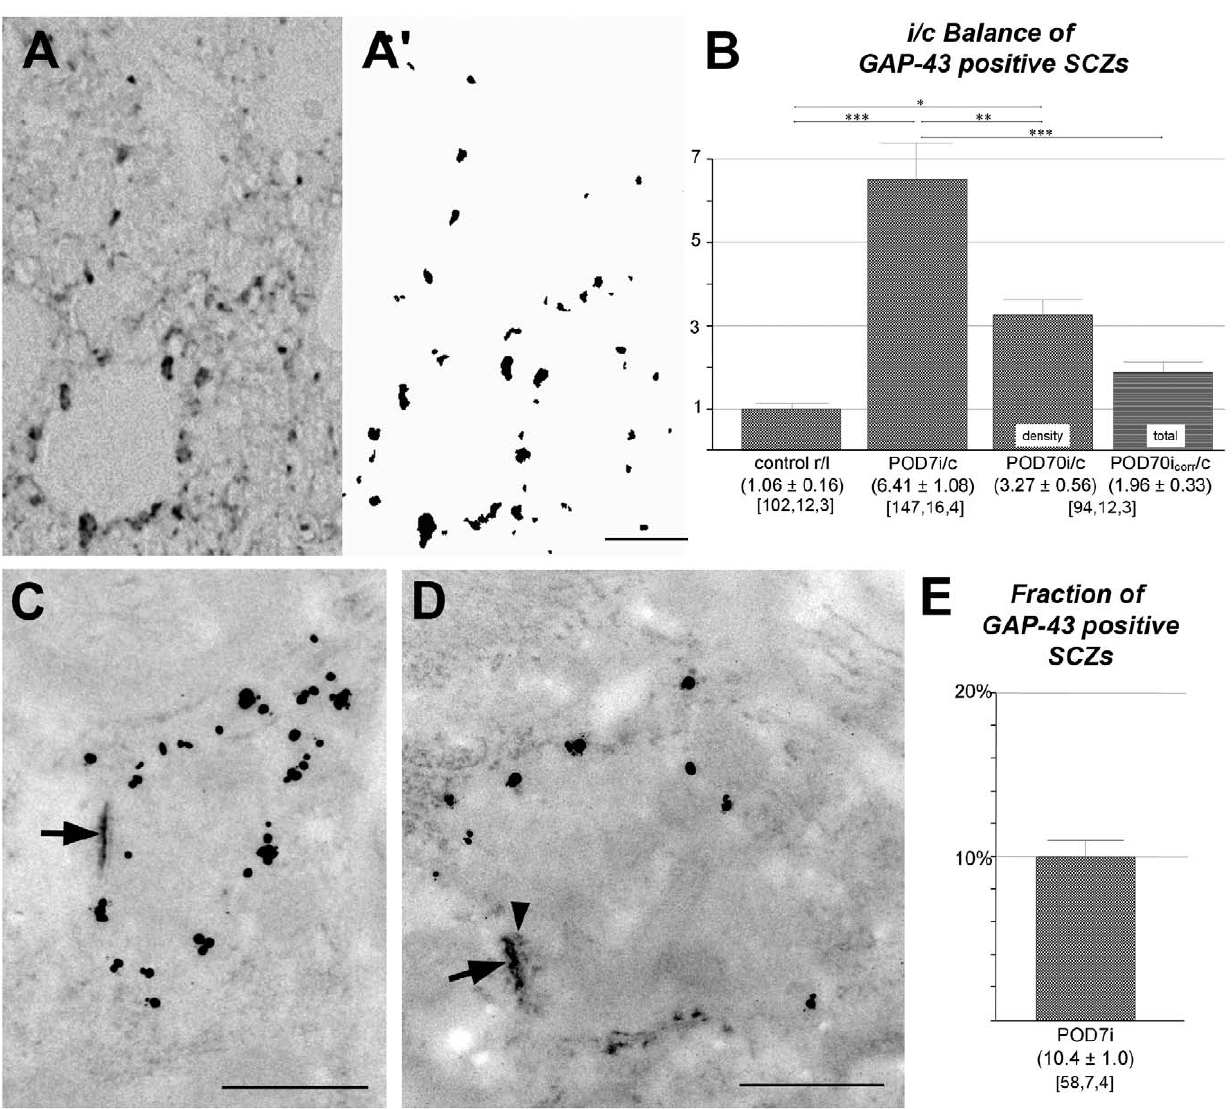
Figure 6. Quantification and ultrastructure of GAP-43 positive profiles in AVCN. (A) Semi-thin section stained for GAP-43 immunoreactivity. (A’) Frame shown in A rendered for computer-based image analysis and quantification. Scale bar =20 m m. (B) Ipsilateral-to- contralateral ratio of GAP-43 positive profiles in controls and after 7 and 70 days of cochlear ablation. The right-most column shows counts after correction (corr) for tissue shrinkage to indicate the relative total of GAP-43 positive profiles present by POD70. (C) Ultrastructure of a synaptic contact by POD7 showing rich immunogold staining for GAP-43 typically located inside the presynaptic ending, avoiding occupation of SCZs which is here distinctly immature as revealed by EPTA staining (arrow). Scale bar =0.5 m m. (D) Another synapse present by POD7 with a more mature contact zone (arrow, arrowhead points to row of presynaptic protrusions) and correspondingly less GAP-43 immunogold labeling. Scale bar =0.5 m m. (E) Fraction of GAP-43 positive synaptic contacts among all SCZs present by POD7 on the lesioned side (i). Numeric triplets below columns as in Fig. 1.